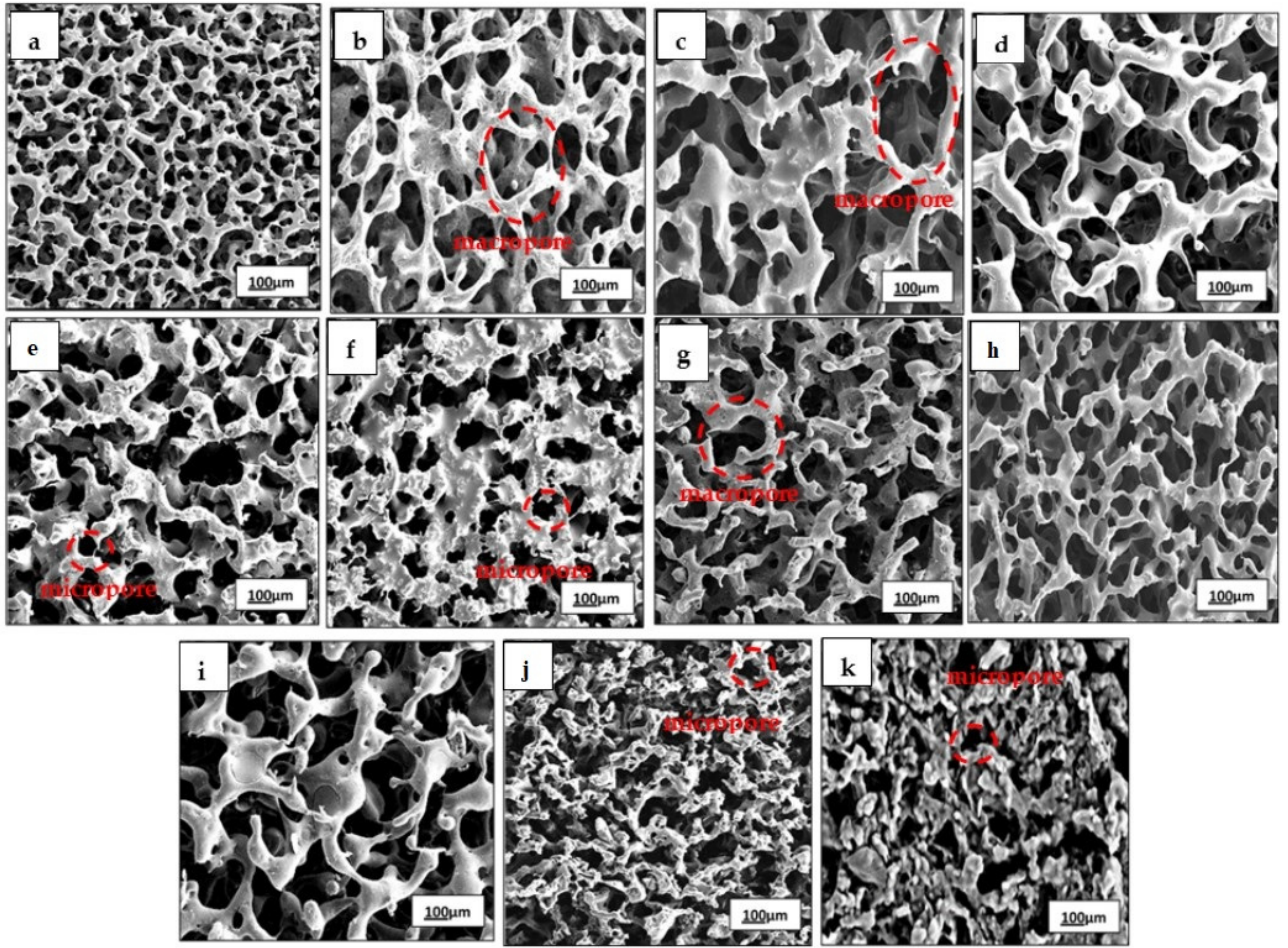
Figure 2. Micrograph of porous structure of ( a ) control-P(3HB- co -4HB), (b) SCCC 2.5 wt.%, ( c ) SCCC 5 wt.%, ( d ) SCCC 7.5 wt.%, ( e ) SCCC 10 wt.%, ( f ) SCCC 12.5 wt.%, ( g ) SBCC 2.5 wt.%, ( h ) SBCC 5 wt.%, ( i ) SBCC 7.5 wt.%, ( j ) SBCC 10 wt.% and ( k ) SBCC 12 wt.%.